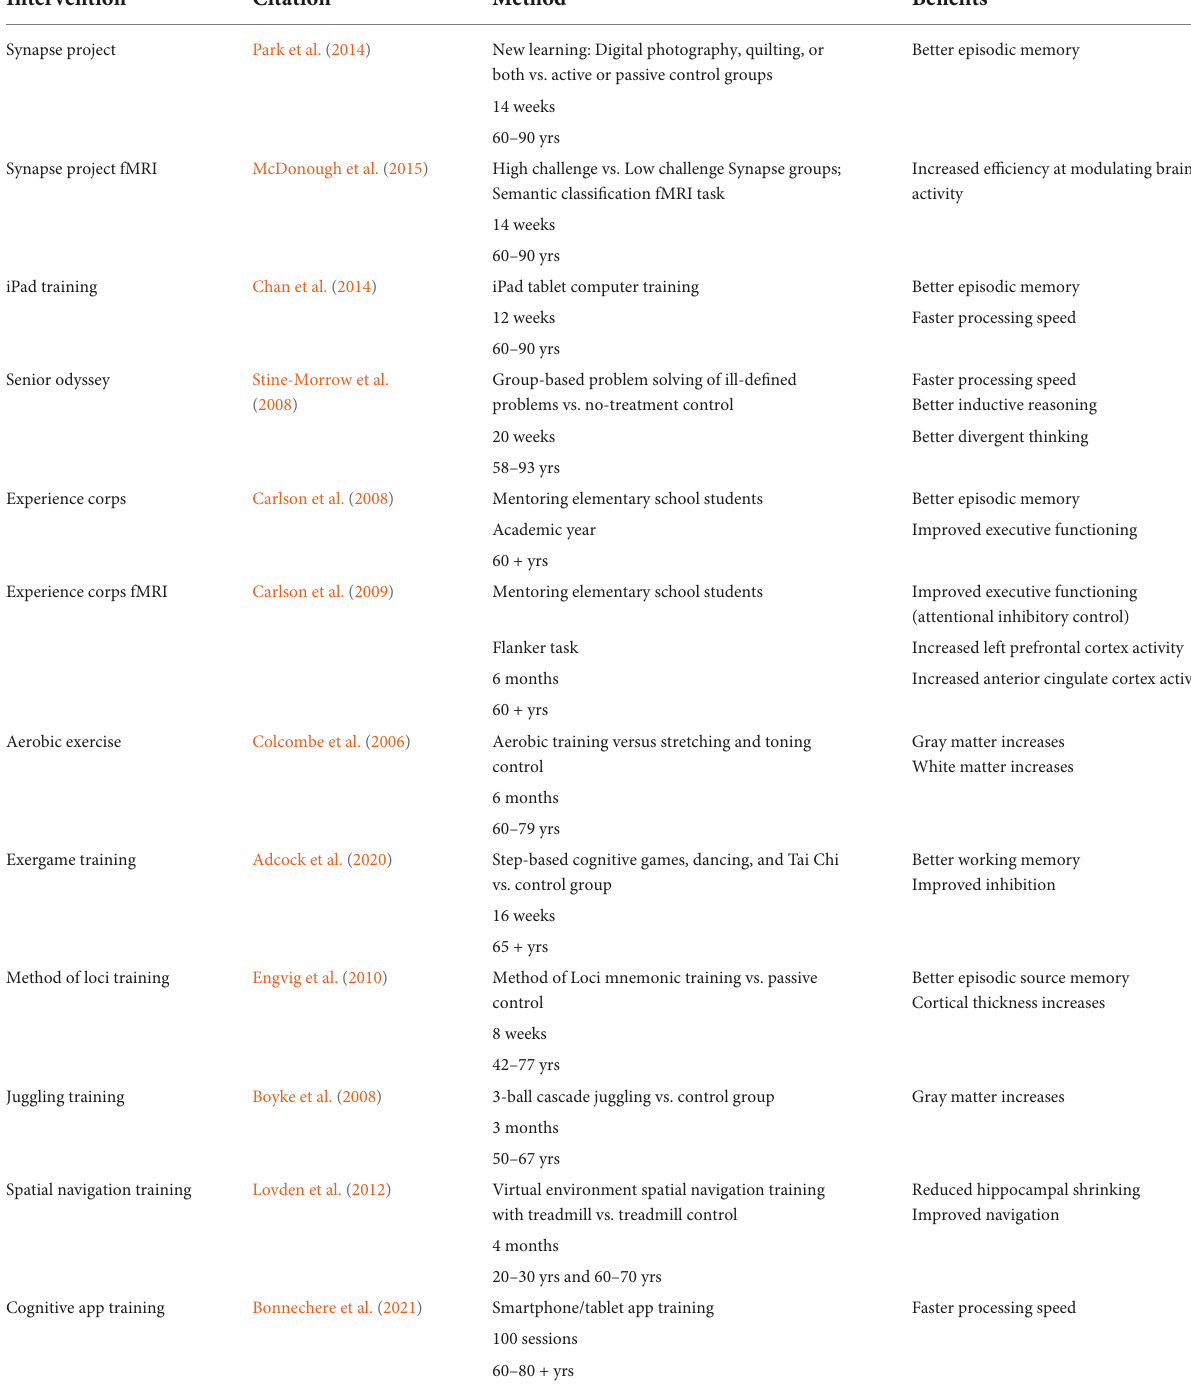
TABLE 1 Example lifestyle interventions and their impacts on cognitive